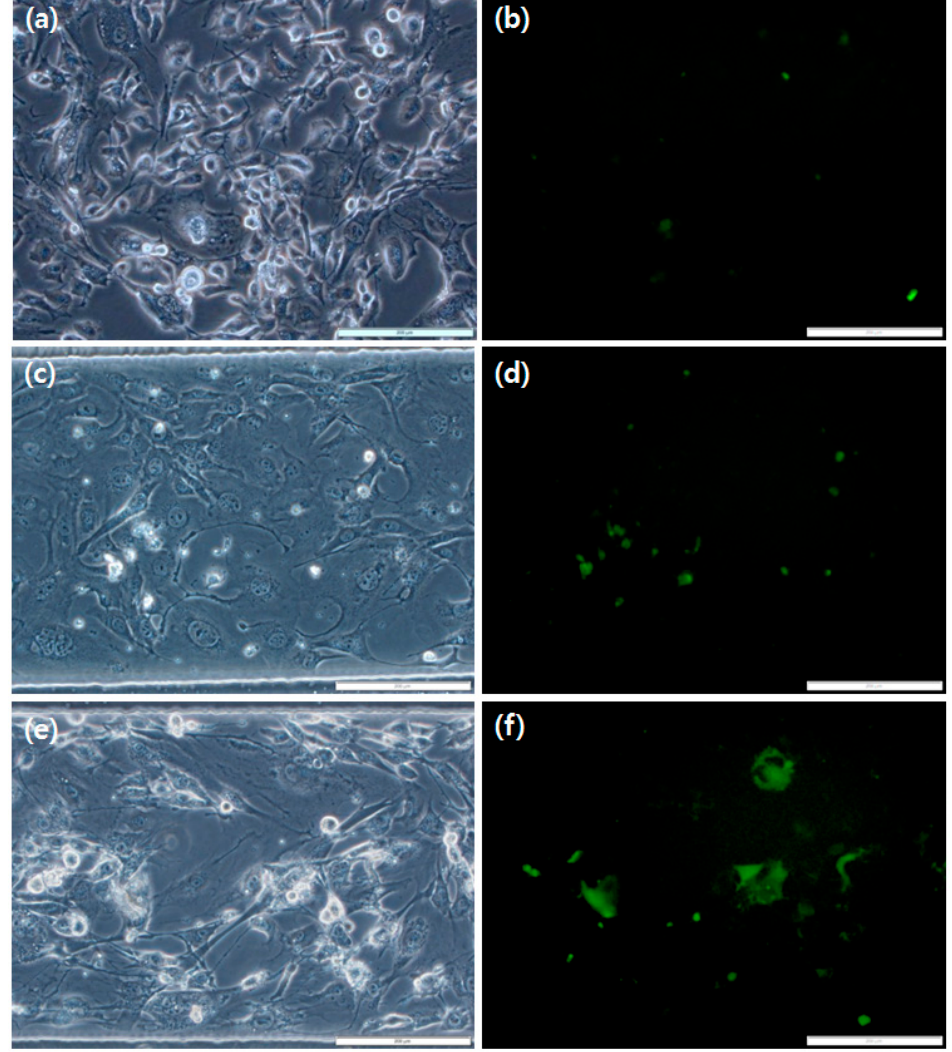
Figure 6. Optical images of NIH/3T3 cells and EGFP virus-infected cells after four days of culture. ( a , b ) Control, ( c , d ) static cell culture in microchannels and ( e , f ) dynamic cell culture system. Dimensions of the microchannel: 500 μ m (W) × 126 mm (L) × 150 μ m (H); flow rate of the dynamic culture: 4 μ L/min, scale bar: 200 μ m).